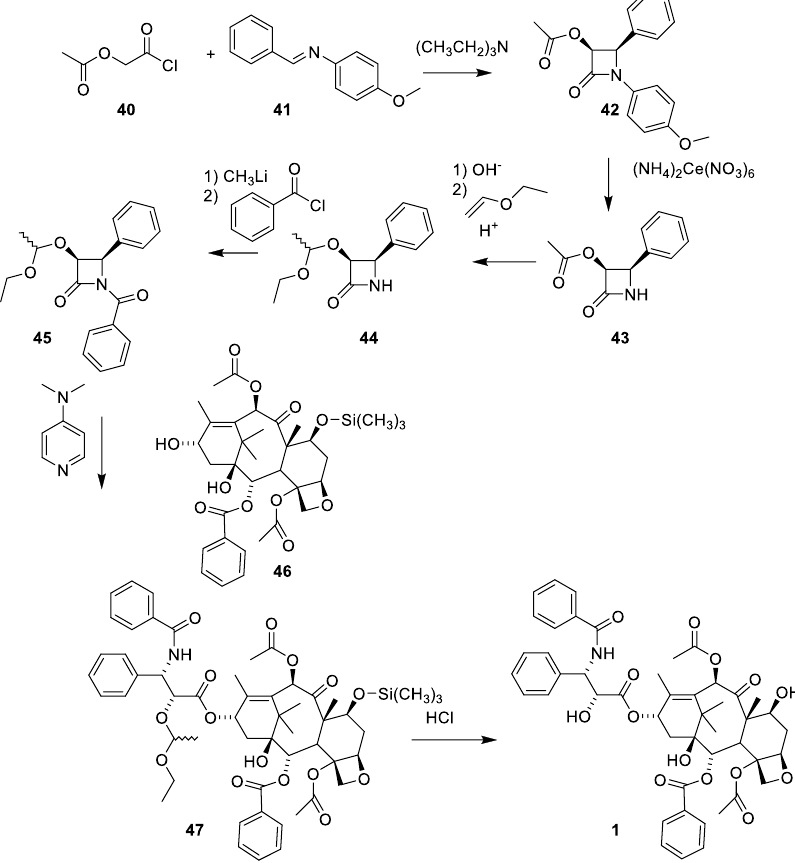
Figure 12. Preparation of paclitaxel ( 1 ) by semi-synthesis from trimethylsilylatedbaccatin III ( 46 ) taking advantage of the acylating properties of β -lactames. The stereochemistry of the intermediates is complicated by the chiral-protecting group [52]. The prepared paclitaxel is contaminated with the isomer with opposite stereochemistry in the isophenylserine group.